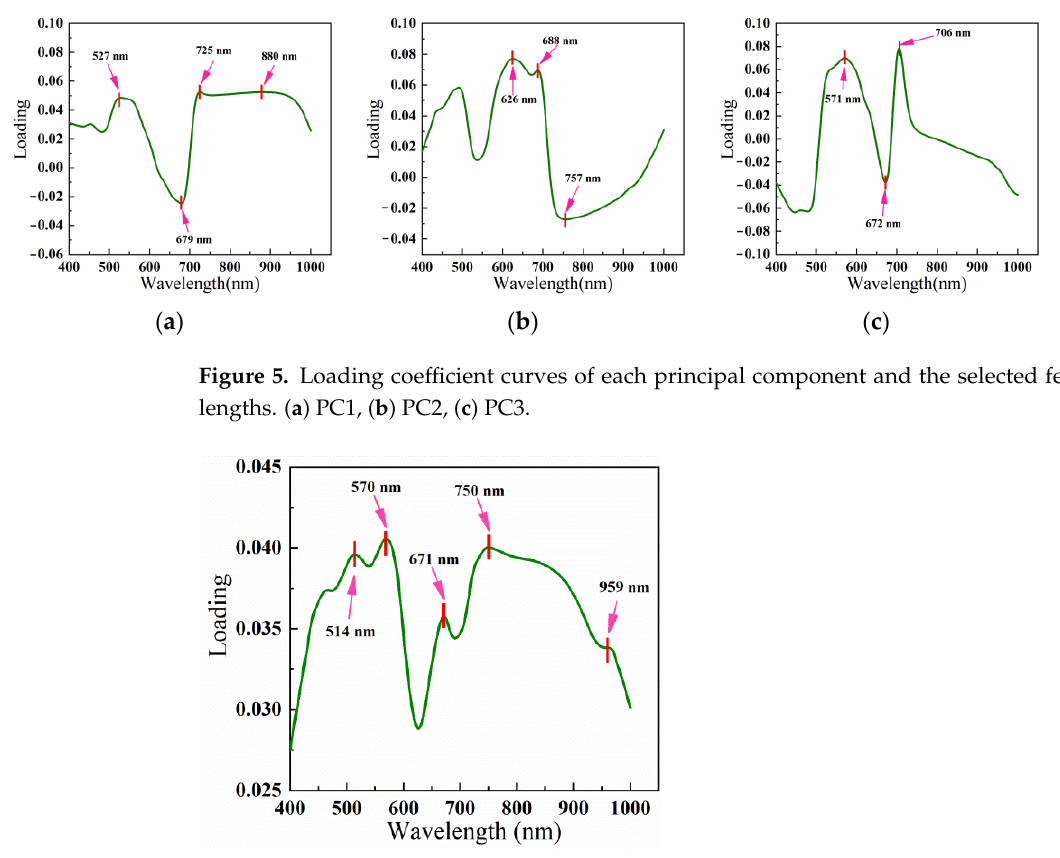
Figure 6. Loading coefficient curves of the improved PCA loading method and the selected feature wavelengths.